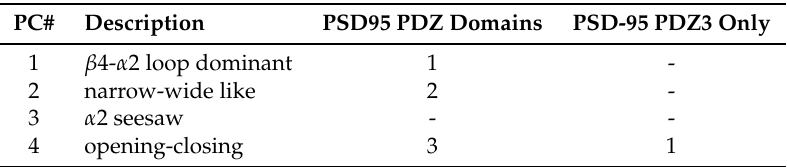
Figure 7. Comparison of the free and bound conformations of selected PDZ domains in the PCA generated for the extended PDZ set. On each plot from ( a – e ) the same data points are shown as in Figure 5 but only for selected domains and conformers. ( a – c ) PDZ domains 1–3 of PSD-95, respectively. The dynamic ensembles are shown along with some relevant PDB structures. ( d , e ) ensembles for the MAGI-1 PDZ and PTP-BL PDZ2 domains selected on the basis of chemical shift data from short and long simulations (see Methods), along with corresponding PDB structures. ( f ) overlap of PCs calculated for the PSD-95 PDZ domains only (same analysis as in Figure 6) and for the extended domain set (shown in Figure 5). Table 3. Correspondence of selected principal components identified for the extended PDZ set in other PDZ sets analyzed in this